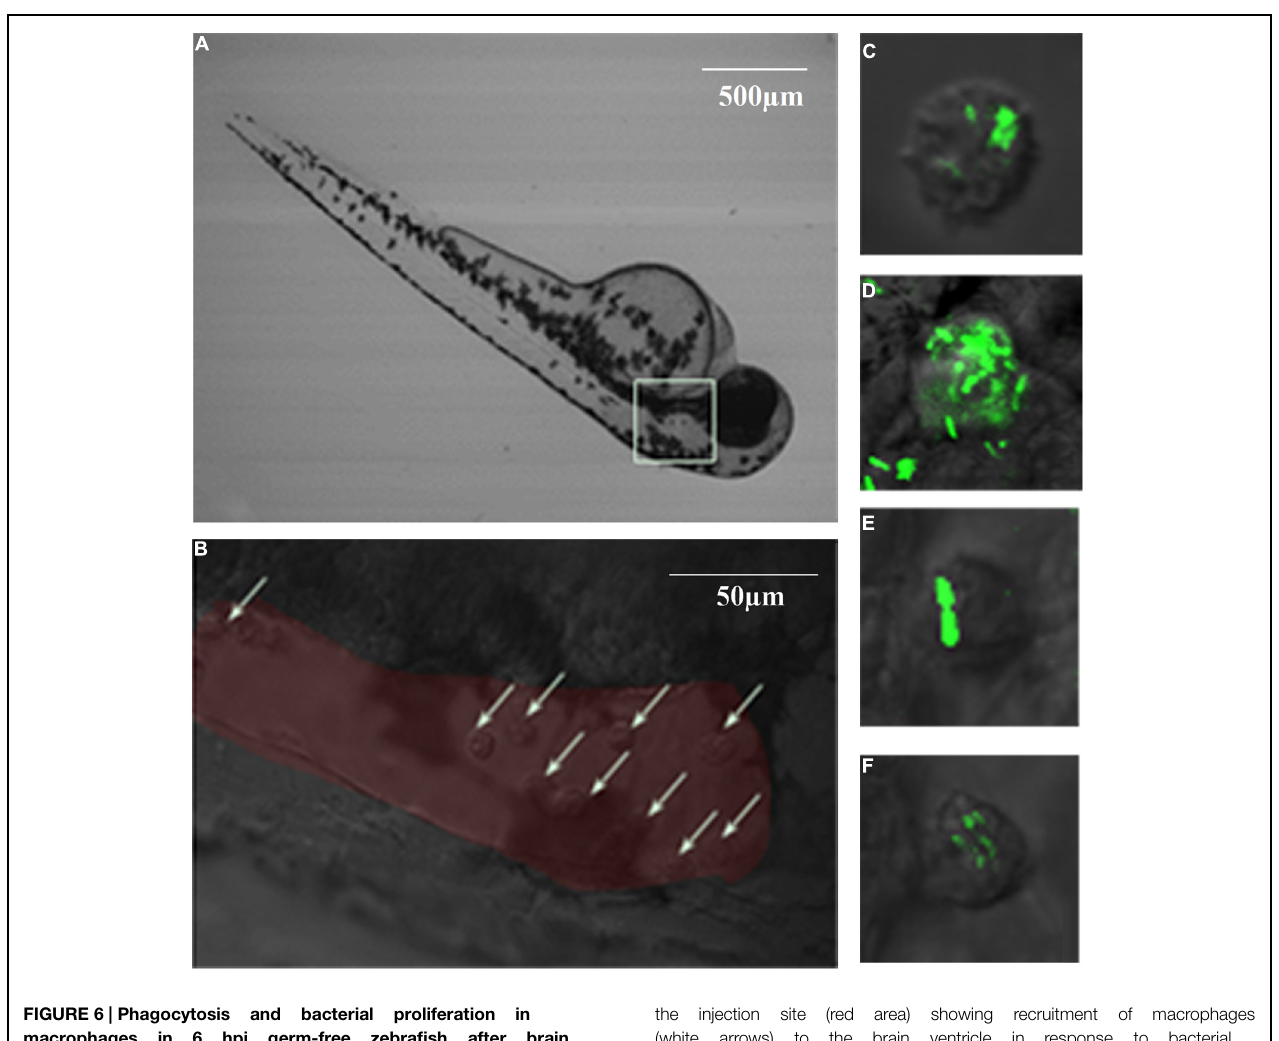
the injection site (red area) showing recruitment of macrophages (white arrows) to the brain ventricle in response to bacterial infection; (C–F) : GFP-expressing bacteria were engulfed by